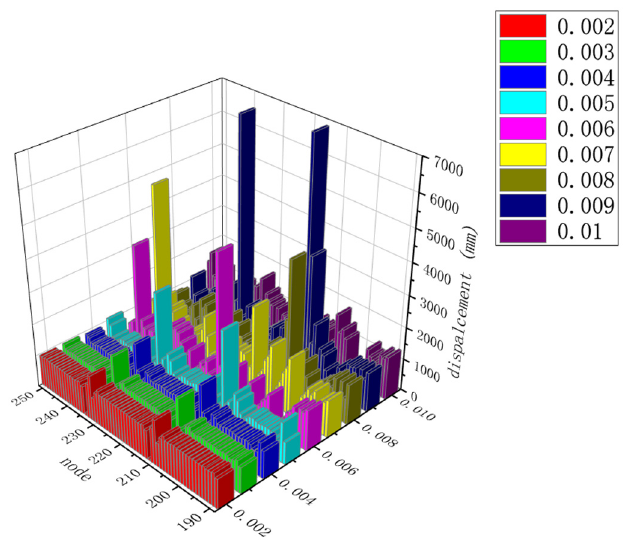
Figure 11. Node displacement diagrams under different thicknesses.